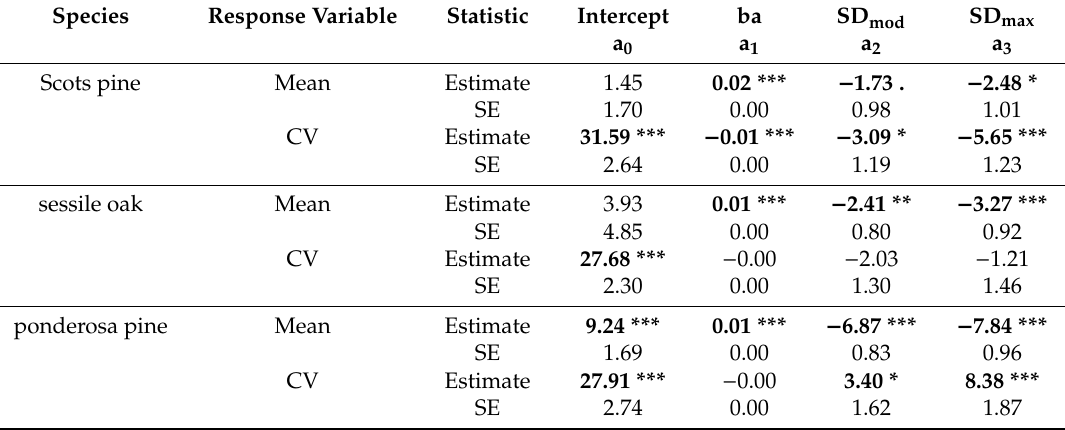
Table A3. Results of the linear mixed-e ff ects model regressions from Equation (7). We test the e ff ect of tree basal area ( ba , cm 2 ), and stand density level ( SD min , SD mod , SD max ) on the mean tree growth ( Mean , cm 2 yr − 1 ) and the mean growth sensitivity ( CV , %). The number of observations was always n = 139 for Scots pine, n = 135 for sessile oak and n = 135 for ponderosa pine. Bold values are significant